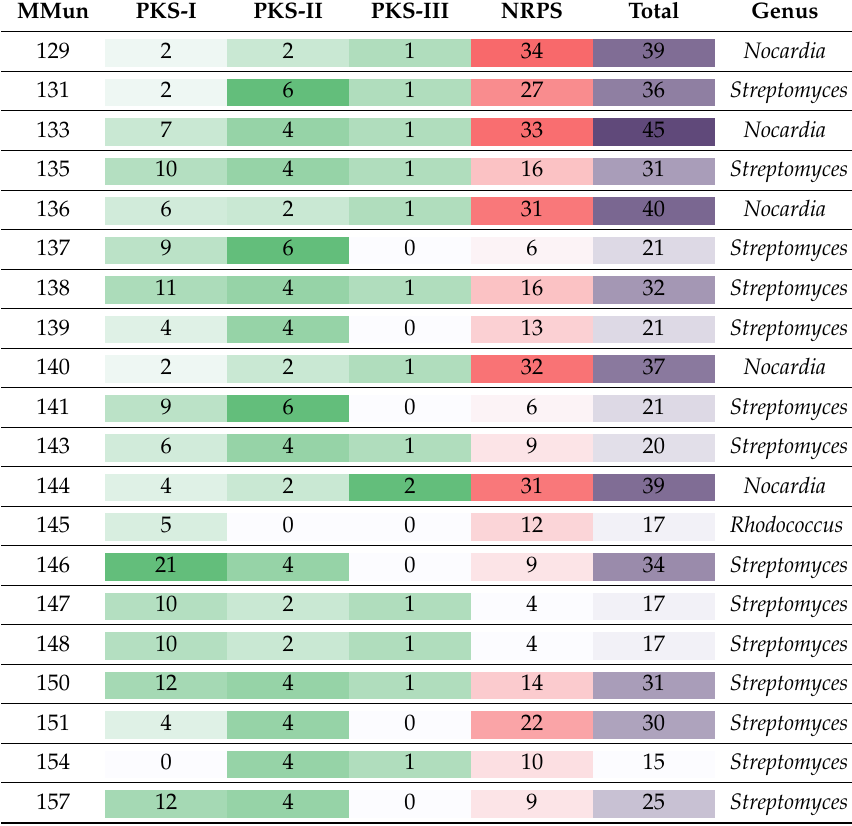
Table 2. Number of biosynthetic gene clusters (BGCs) based on genome mining of 22 MMun